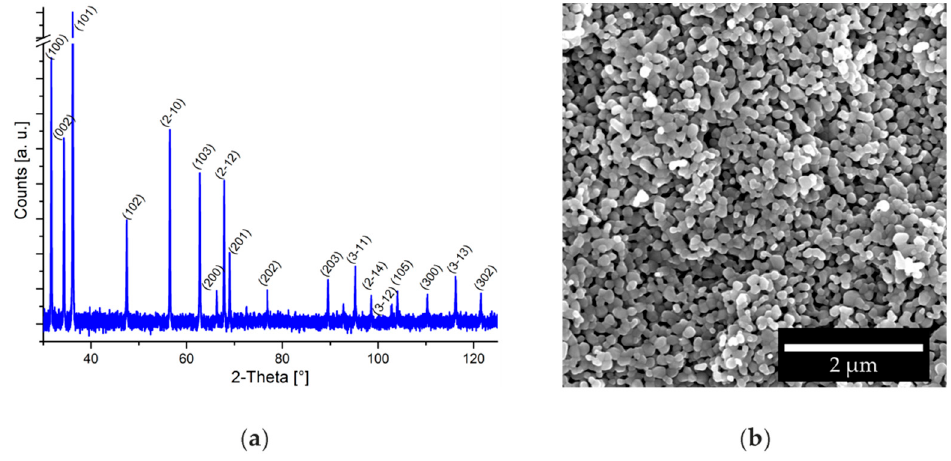
Figure 1. ZnO green body. ( a ) Theta-2-Theta X-ray powder diffraction measurement reveals the expected polycrystalline behavior. ( b ) SEM image of the surface of the pressed green body specimen.